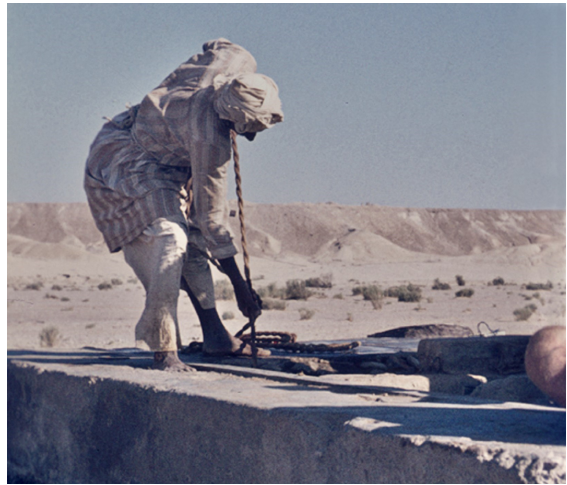
Figure 10 The well of Kuntila, on Darb